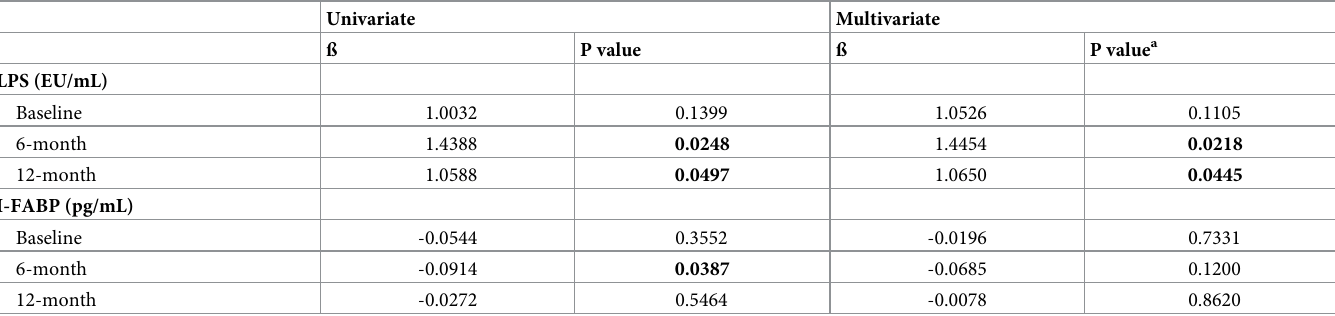
Table 2. Linear regression of IGF-1 concentrations by EED